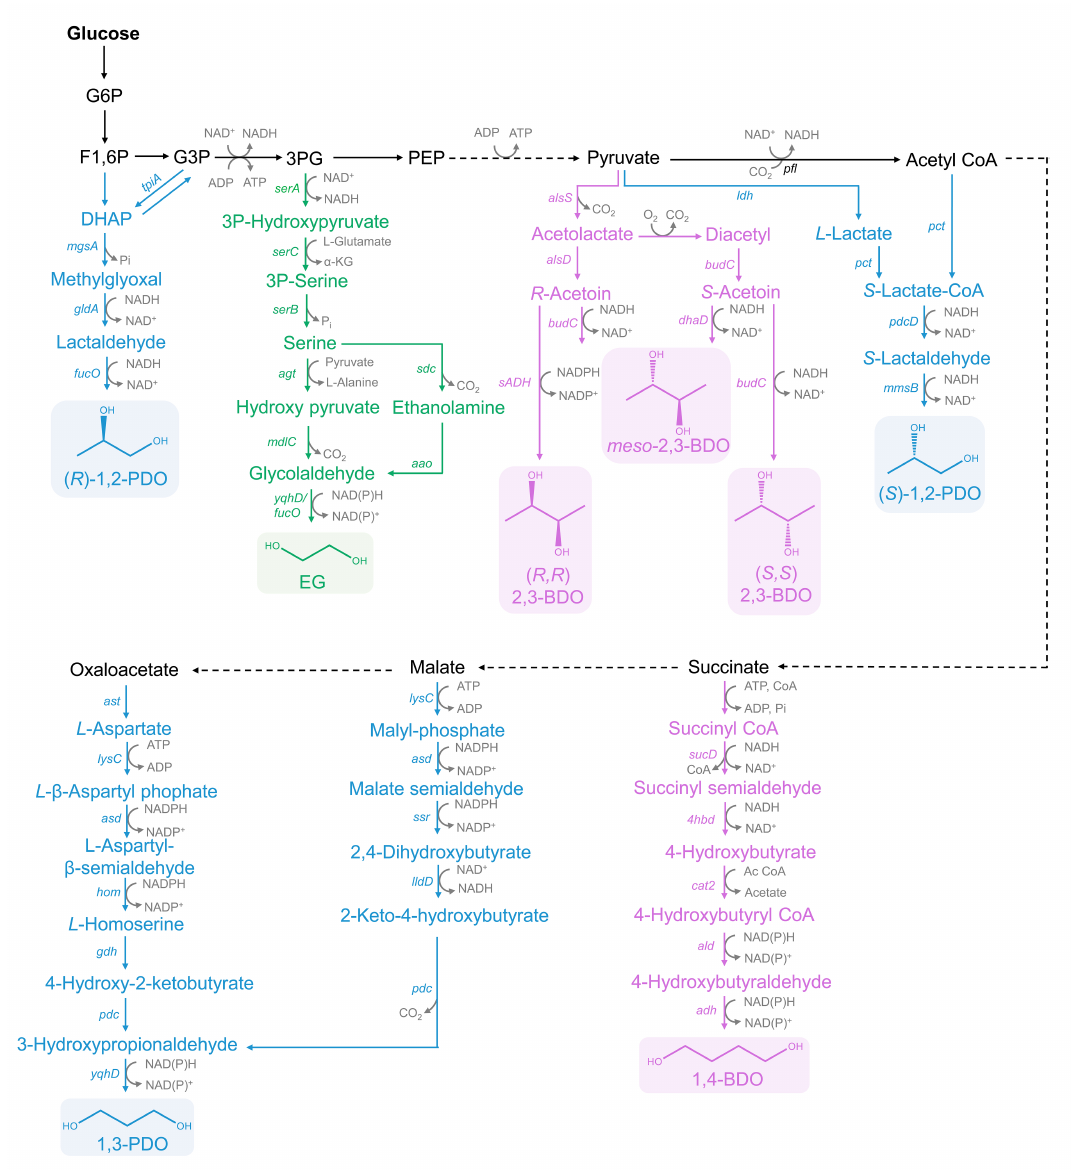
Figure 1. Biosynthetic pathways of diols from glucose in E. coli. mgsA : methylglyoxal